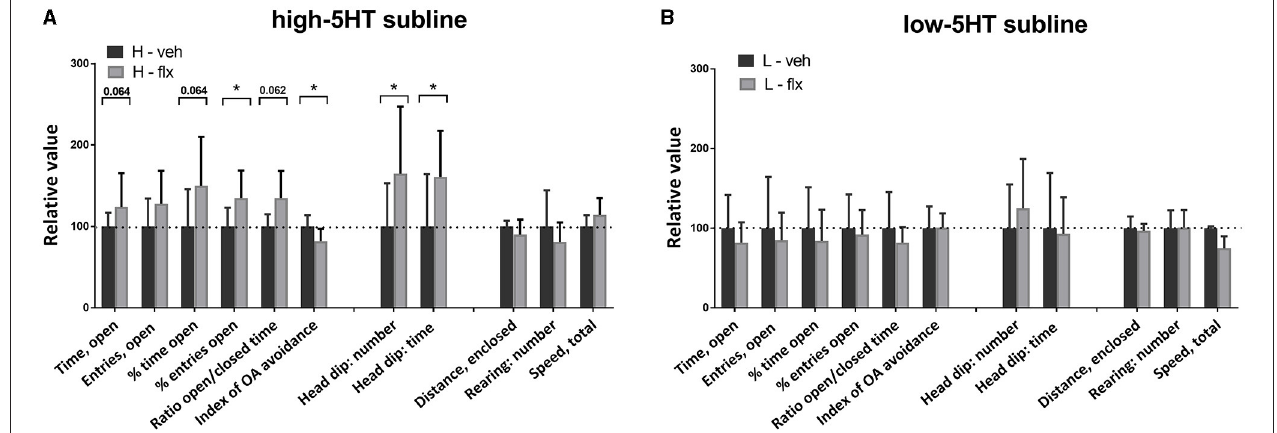
FIGURE 5 | Effect of 22-day fluoxetine treatment on the behavior of (A) high-5HT and (B) low-5HT animals in the elevated plus maze test. For detailed explanation see legend to Figure 4 . Complete statistical data and absolute values of all measured parameters are provided in Supplementary Table 3 . * p < 0.05.